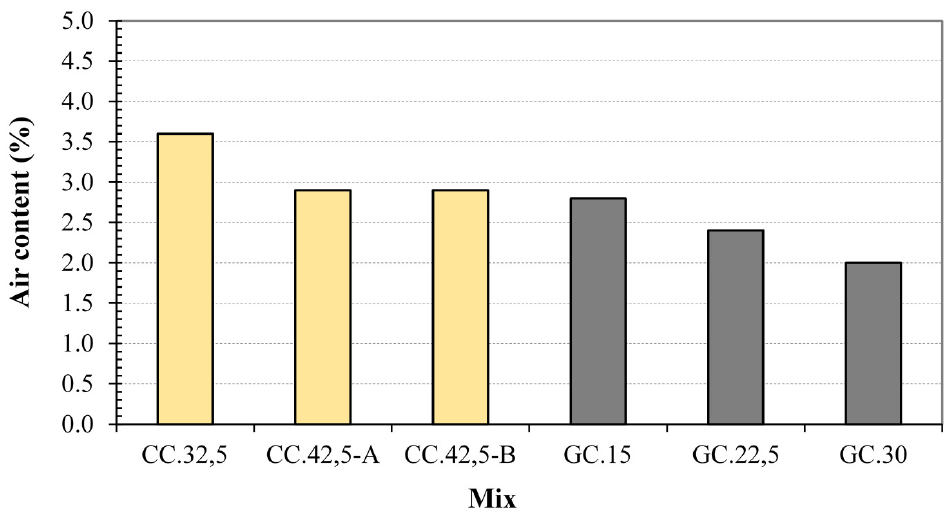
Figure 7. Air content of the mixes.